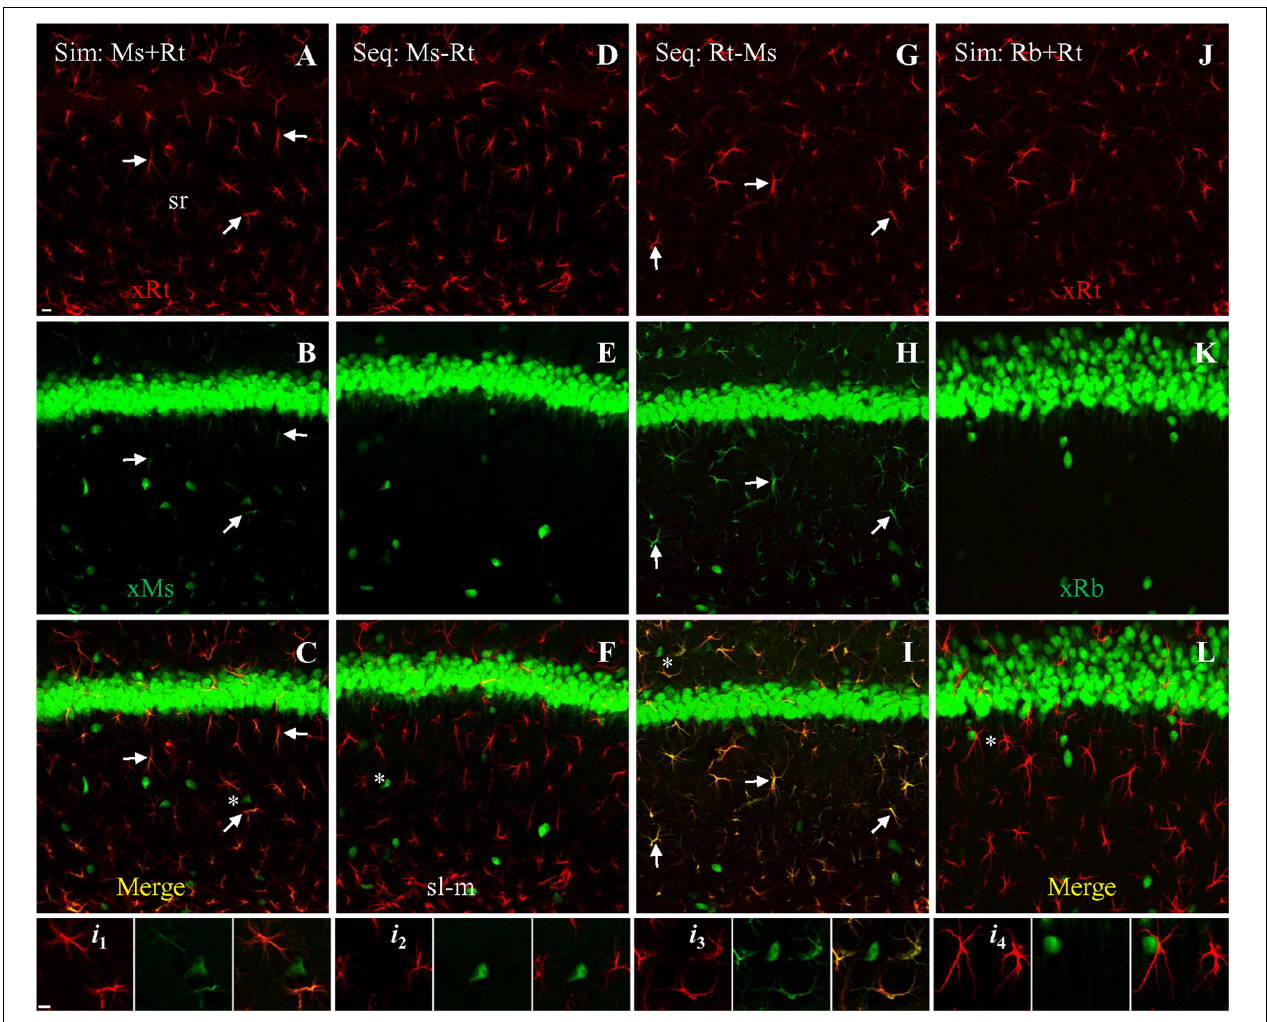
FIGURE 2 | Double staining with both rat anti-GFAP and mouse anti-NeuN primaries using different protocols, visualized with goat-derived secondaries. Single confocal photomicrographs acquired from hippocampal area CA1. (A–C) Simultaneous staining (Sim) with a mixture of both primaries, visualized with a mixture of goat anti-rat ( A , red) and anti-mouse ( B , green) secondaries. Note in (B) that the anti-mouse secondary stained mouse anti-NeuN in neuron cell bodies as expected, but also stained the cross-species primary rat anti-GFAP in astrocytes. (D–F) First sequential protocol (Seq) by completing staining with mouse anti-NeuN primary (visualized with anti-mouse secondary), followed by staining with rat anti-GFAP primary (visualized with anti-rat secondary). Note the absence of astrocytic staining in E, indicating that mouse-then-rat sequential staining did not result in cross-species astrocytic staining of rat anti-GFAP by anti-mouse secondary. (G–I) Second sequential protocol by completing staining with rat anti-GFAP primary (visualized with anti-rat secondary), followed by staining with mouse anti-NeuN primary (visualized with anti-mouse secondary). Check the green channel (B,E,H) for cross astrocytic staining and merged channel (C,F,I) for co-staining as orange to yellow color (if any) from all these three protocols. Arrows indicating representative astrocytes co-stained by same- and cross-species binding. (J–L) As negative control for cross-species reaction, simultaneous staining with the rat anti-GFAP primary and a rabbit anti-NeuN primary, visualized with a mixture of goat anti-rabbit (green) and goat anti-rat (red) secondaries. No cross astrocytic staining could be seen (K,L) . Stained astrocytes and a nearby neuron from each staining protocol (asterisks) were highlighted in four groups ( i 1 – i 4 ) of three Insets , which indicate the red, green, and merged channel, respectively. Ms/Rb/Rt, (primary) raised in mouse, rabbit or rat; sl-m, stratum lacunosum-moleculare; sr, stratum radiatum; xMs/Rb/Rt, (goat) anti-mouse, -rabbit or -rat secondary. Scale bars: 10 µ m in all